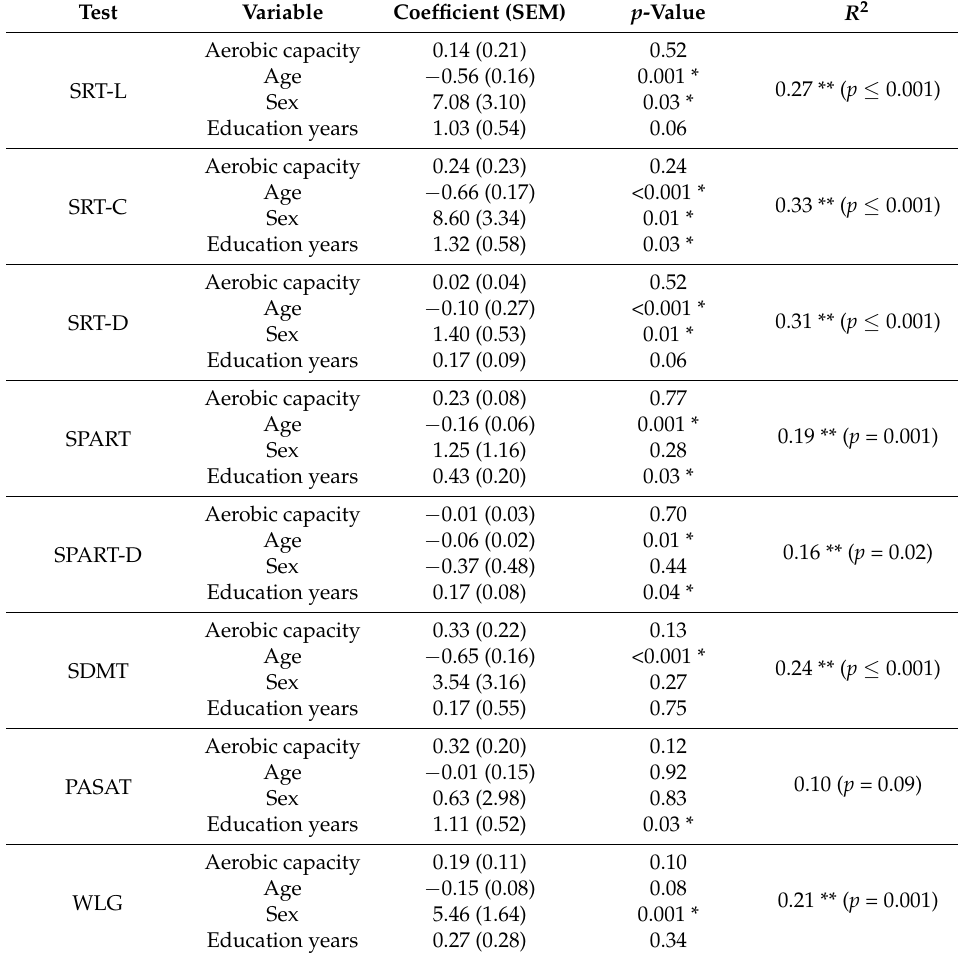
Table 5. Multiple linear regression coefficients between aerobic capacity and cognitive performance, adjusted for sex, age, and education